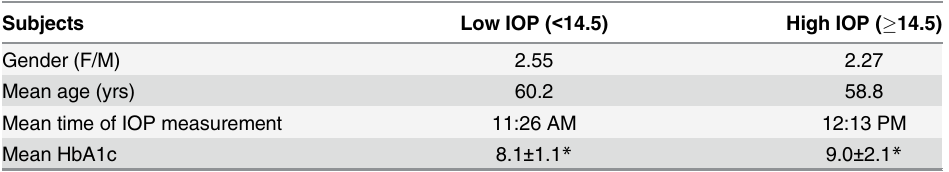
Table 1. Distribution of the study